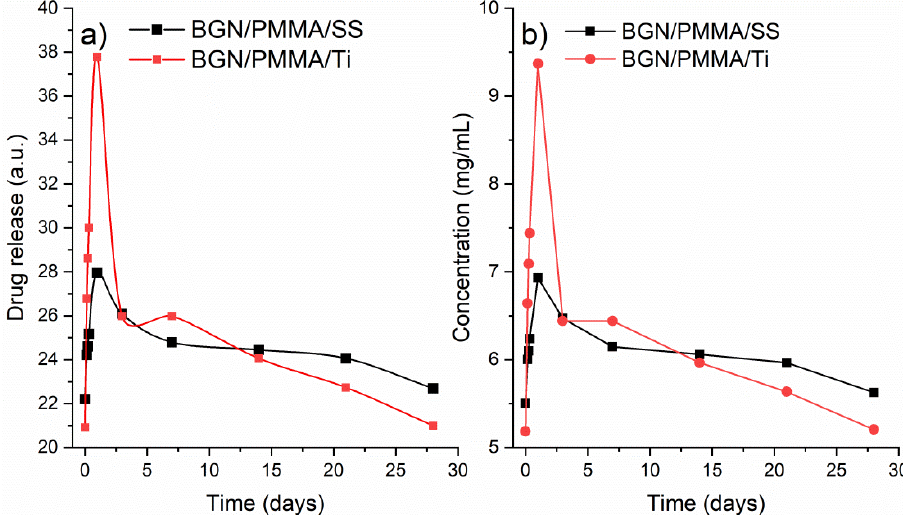
Figure 8. Drug release as function of time for BGN / PMMA / SS (black curve) and BGN / PMMA / Ti (red curve): ( a ) peak absorbance intensity function of time and ( b ) concentration function of time.